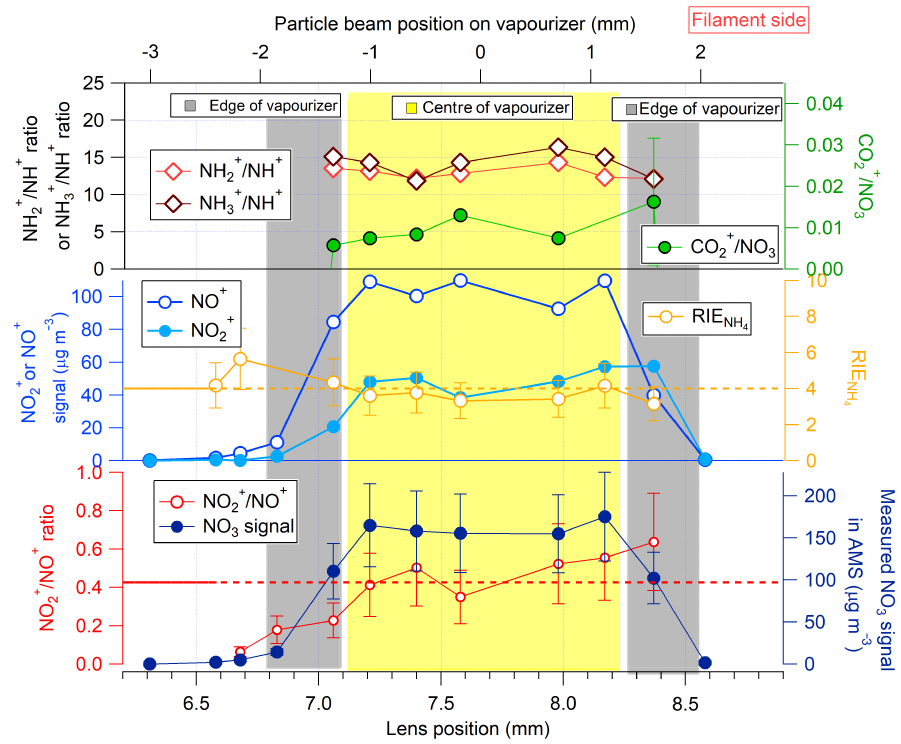
/ NO + , total nitrate, NO + / NH + , NH + / NH + Figure 6. SV: particle beam position dependence of NO + and NO + signals, RIE NH , NH + 2 2 2 3 4 / NO 3 . The shaded areas are a rough indication of where the particle beam hits the vapourizer. A and nitrate equivalent mass ratio of CO + 2 constant IE obtained with pure NH 4 NO 3 particles at the centre of the lens was applied to all data collected in this experiment. The error bars represent the measurement variability (standard deviation) for each point. If only one data point for one position was obtained, the error bar for that point was estimated by averaging those from nearby positions. The particle size-resolved detection for the edge and centre positions are shown in Fig. 7. This experiment was performed in a Q-AMS due to limitations in instrument availability and led to lower signal-to-noise ratios than when using a ToF-AMS, which was used in the rest of this